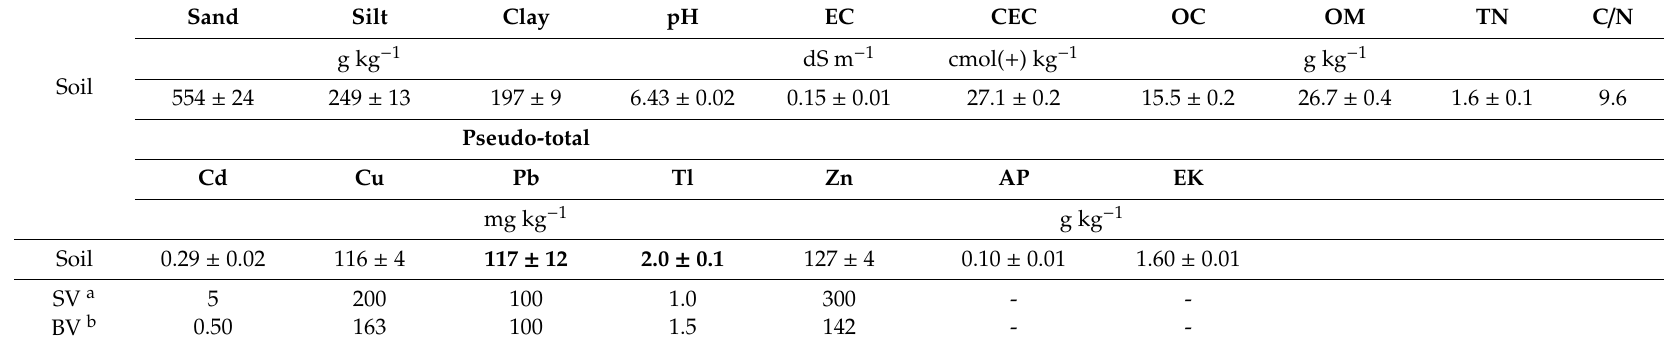
Table 1. Physicochemical properties of the composite soil sample used in the pot experiment before plant sowing (time T0).